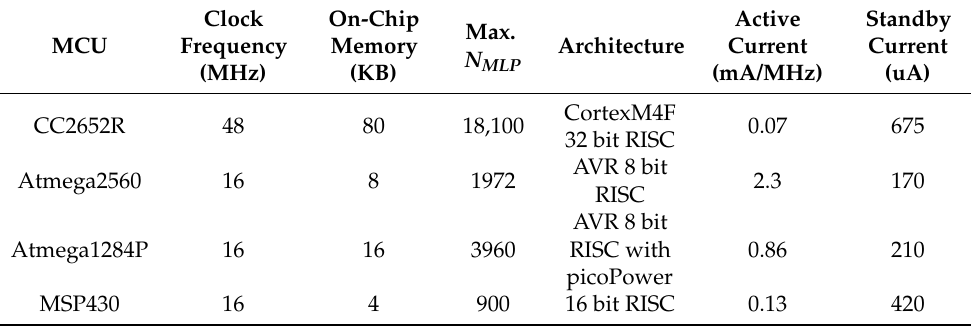
Figure 7. In-house prototype with CC2652R MCU. Table 2. Characteristics of the low-end MCUs used in this work.